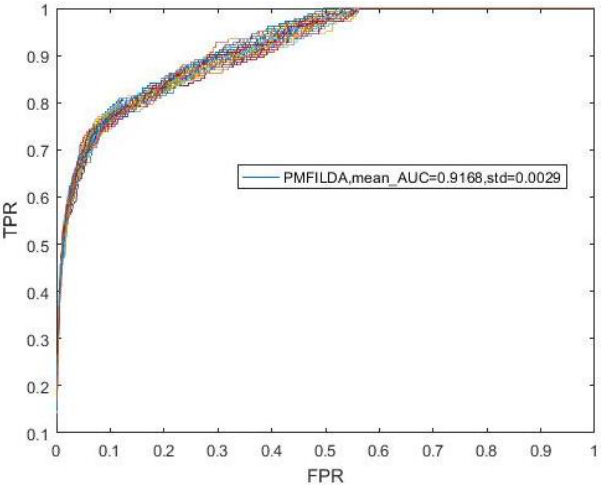
Figure 5. The ROC curve and AUCs of PMFILDA based on the same known 183 lncRNA-disease associations proposed by